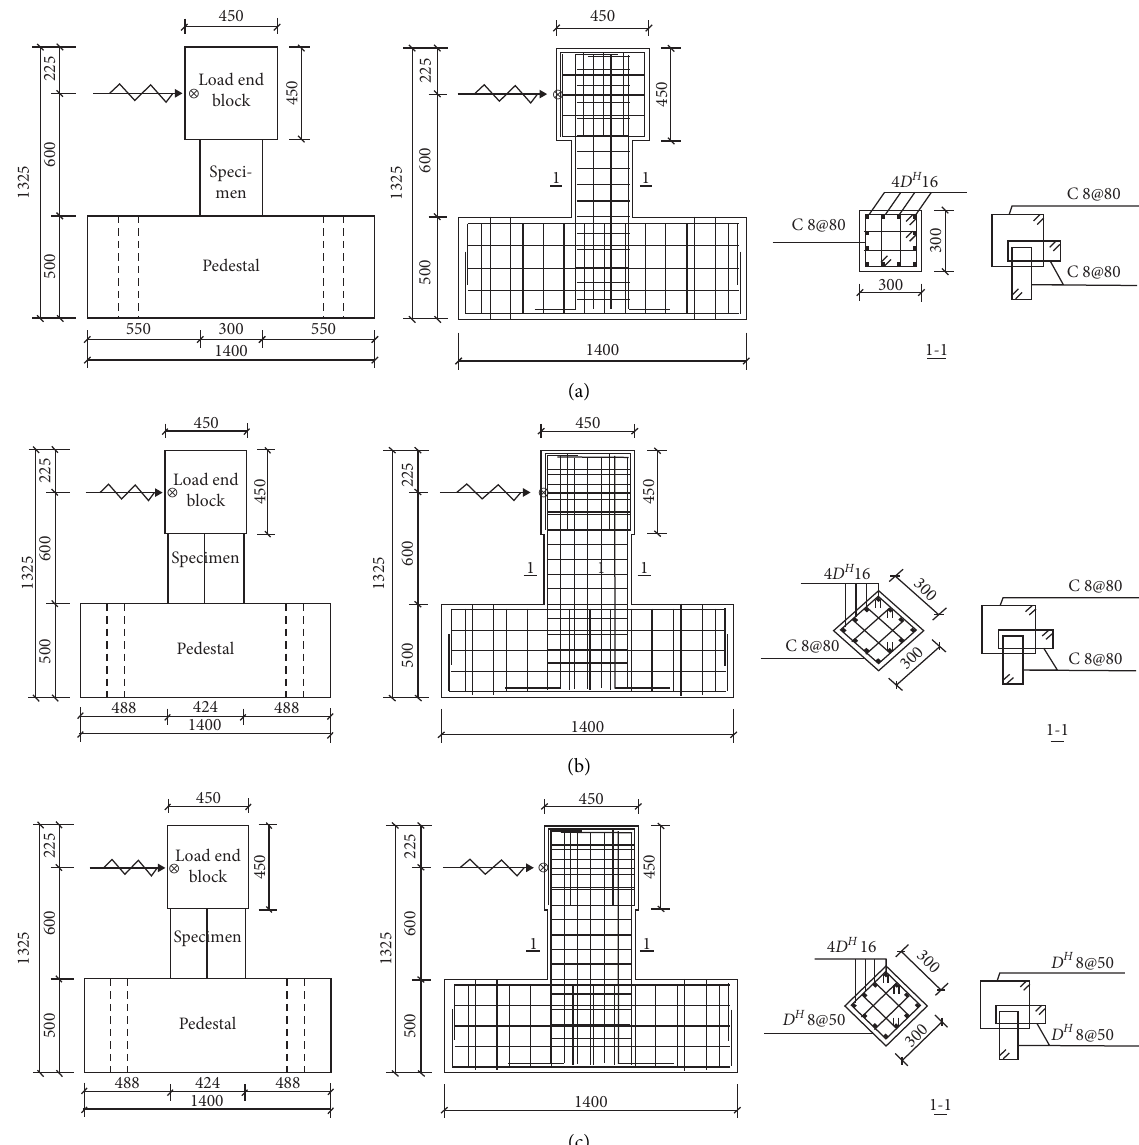
Figure 1: Schematics of prepared specimens, i.e., short column-1 (SC-1) through SC-6, including arrangement of reinforcing bars: D H � HTRB630 steel bar and C � HRB400 steel bar; ⊗ � horizontal load loading point. (a) SC-1. (b) SC-2, SC-3 (c) SC-4, SC-5, and